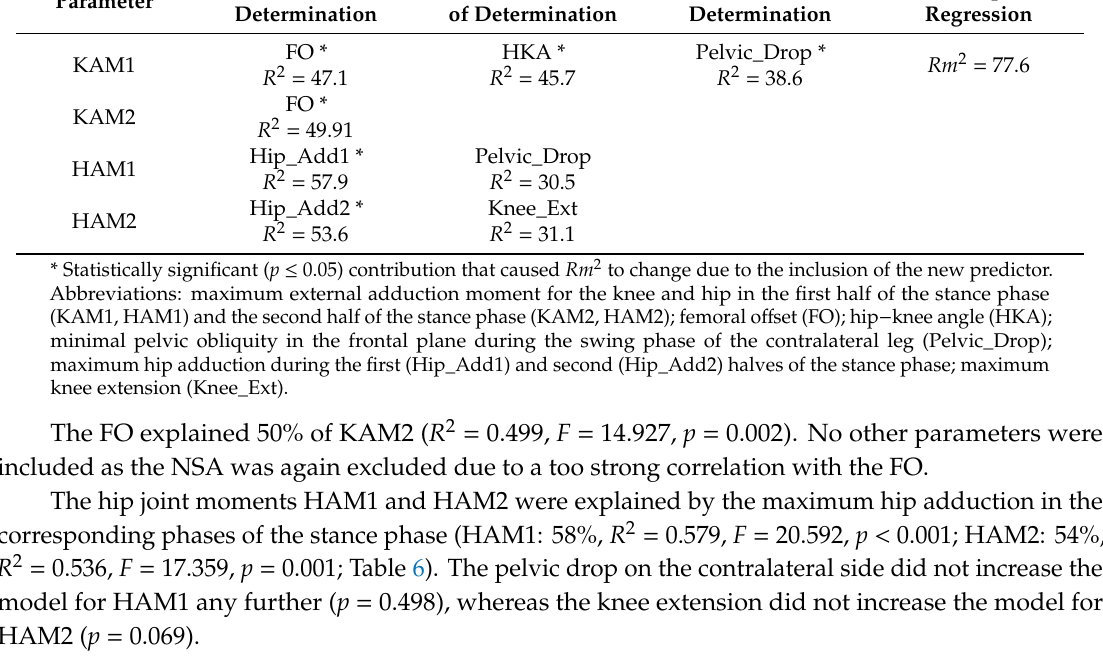
Table 6. Coe ffi cients of determination ( R 2 values (%)) for the external joint moments of the involved side as a function of the single correlating leg alignment or kinematic gait analysis parameters and coe ffi cients of determination ( Rm 2 values (%)) fitted as a function of all the significantly contributing parameters. First Coe ffi cient of Second Coe ffi cient Third Coe ffi cient of Multiple Parameter Determination of Determination Determination Regression FO * Pelvic_Drop * KAM1 Rm 2 = R 2 = 47.1 R 2 = 38.6